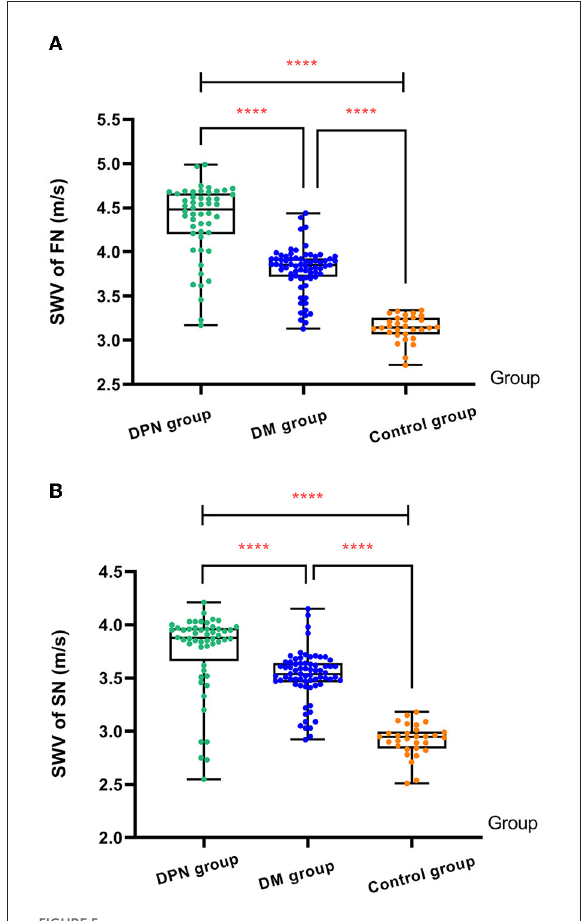
FIGURE5 (A) Comparison of SWV of FN among three groups. (B) Comparison of SWV of SN among three groups. The ****symbol indicates the significant difference between